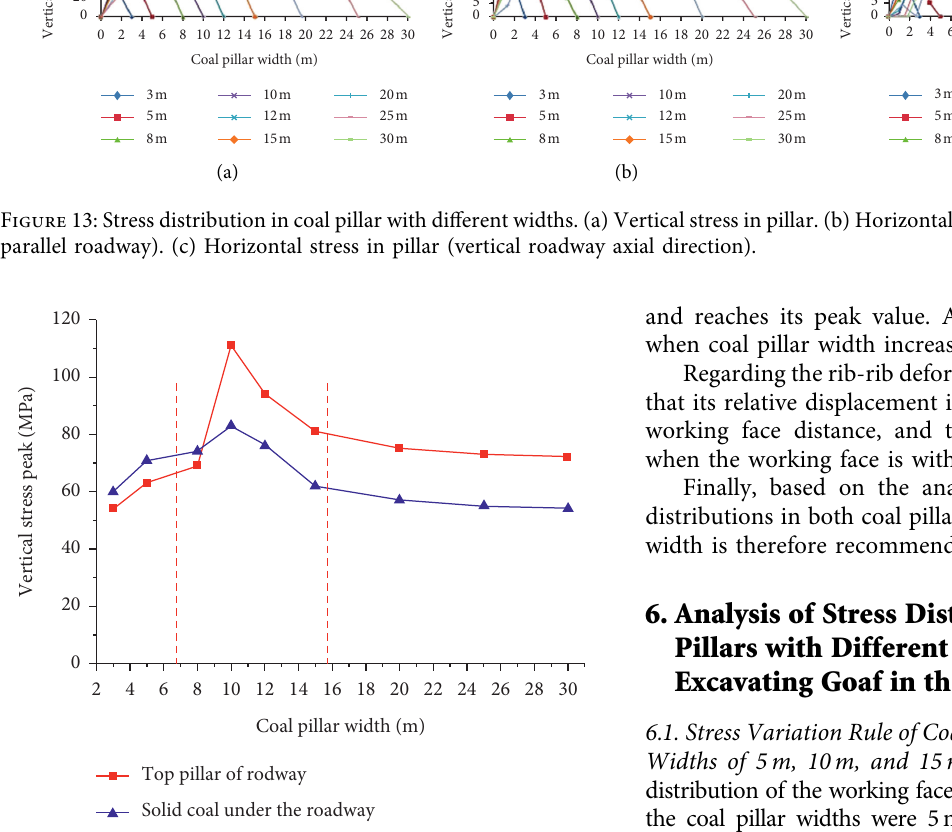
Figure 14: Stress distribution of roadway under different pillar